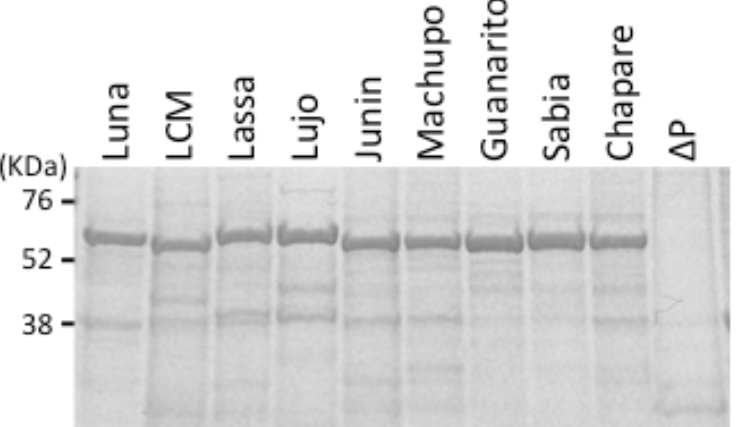
analyzed by sodium dodecyl sulfate-polyacrylamide gel electrophoresis (SDS-PAGE) after staining the gels with Coomassie blue. Purified NP antigens with approximate molecular weights of 62 kDa from Luna, LCM, Lassa, Lujo, Junin, Machupo, Guanarito, Sabia, and Chapare viruses and the purified negative control antigen (ΔP) are